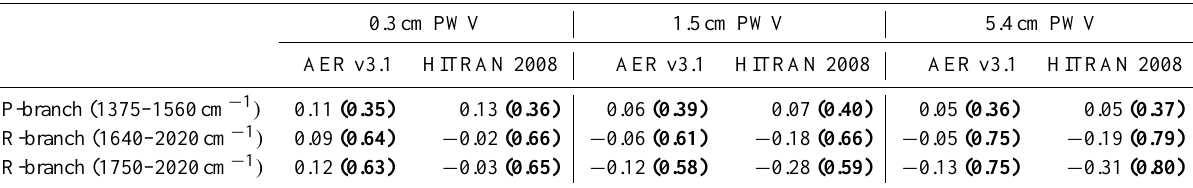
Table 3. Water vapor retrieval brightness temperature residuals (mean and RMS in K, RMS in bold) for LBLRTM v12.1 when the H 2 O line parameters from HITRAN 2008 and those from AER v3.1 are used.